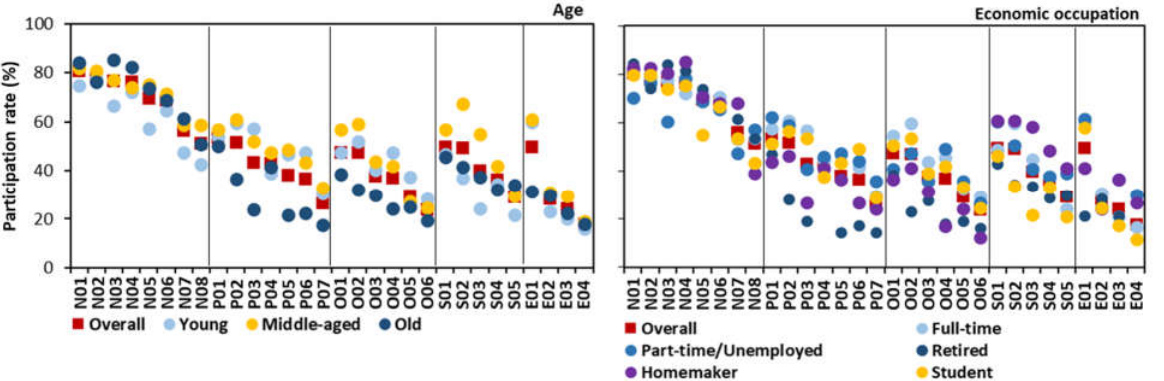
Figure 4. The participation rate (%) in 30 activity types with reference to the socio-economic factors of age and economic occupation. Note. Refer to Table 3 for the codes of the activity types.